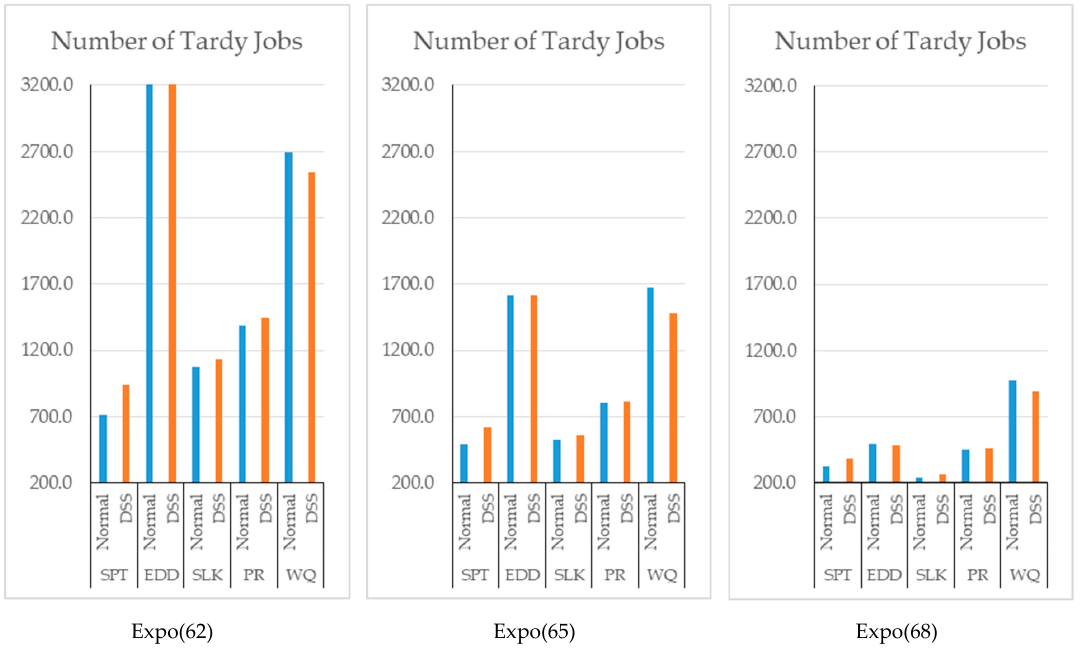
Figure 8. Number of Tardy Jobs.